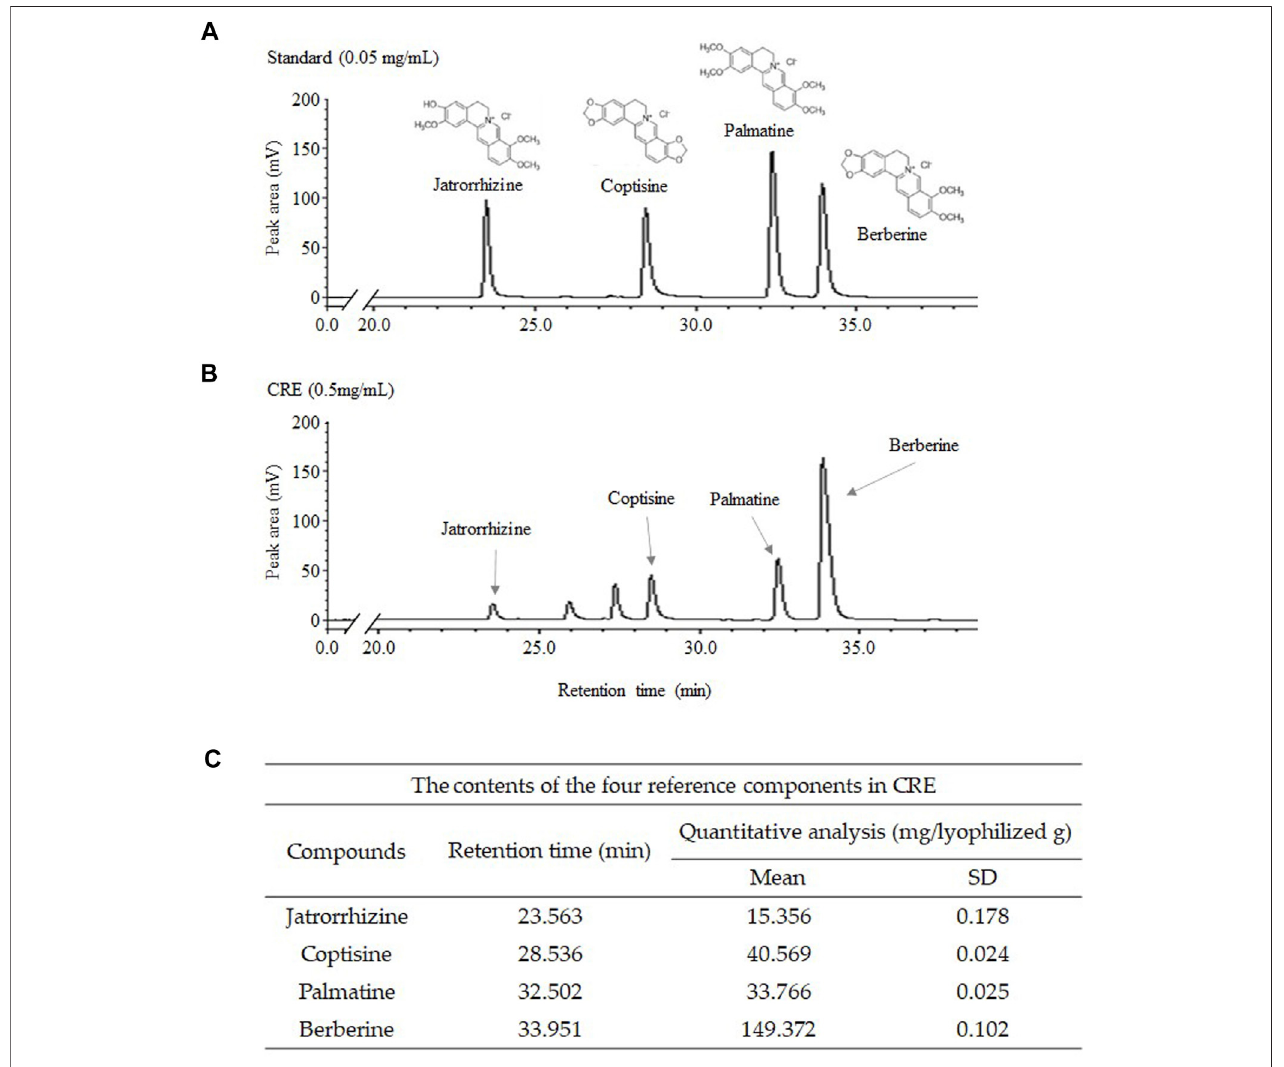
FIGURE 1 | Fingerprint analysis of CRE and standards. CRE and the four reference compounds were analyzed using HPLC – PDA, and the fi ngerprinting results were acquired at wavelengths of 265 nm (A,B) . The level of major compounds in CRE was quanti fi ed (C) .